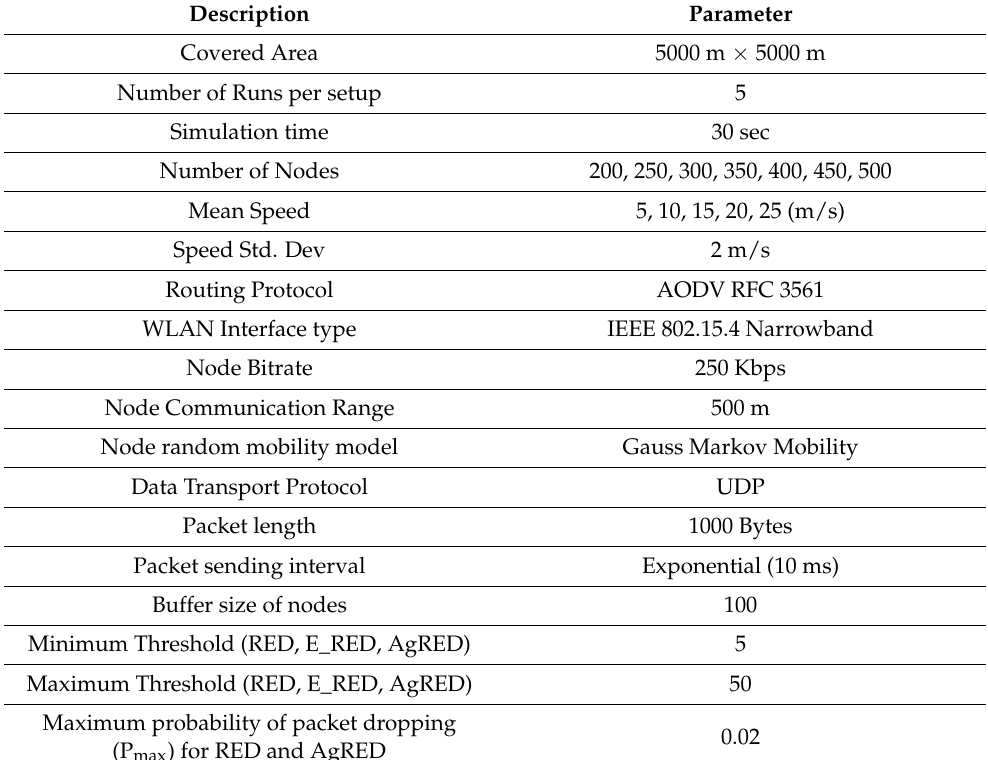
Table 1. Simulation